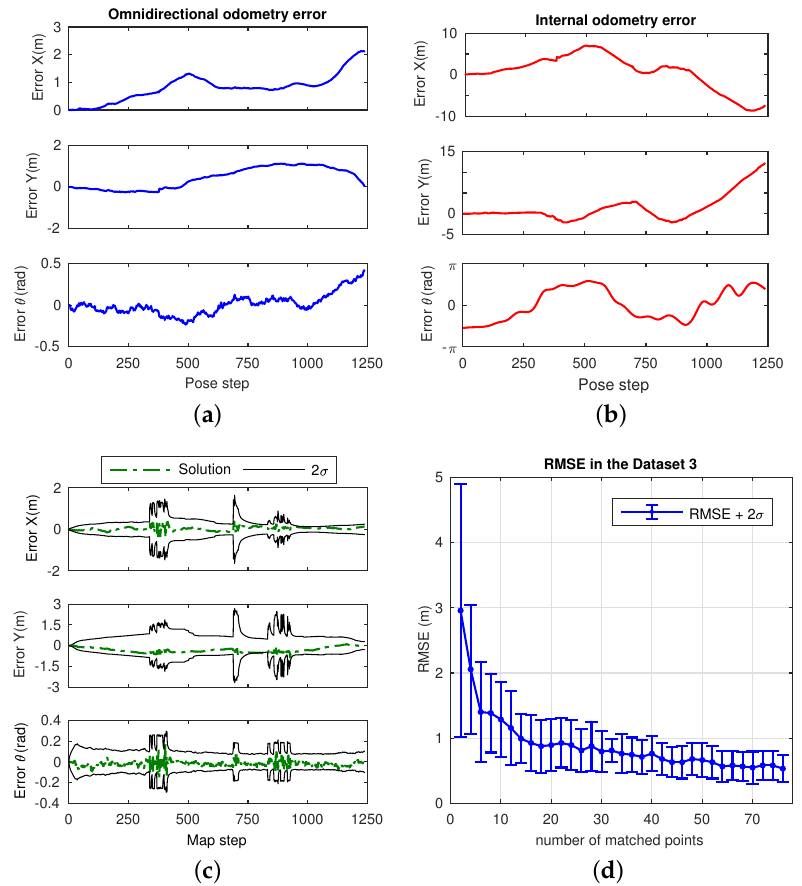
Figure 23. Error results in Dataset 3: ( a ) error in the omnidirectional visual odometry (Figure 22a) in X , Y and θ ; ( b ) error in the internal odometry for comparison purposes; ( c ) error terms for the SLAM estimation presented in Figure 22b; ( d ) RMSE (m) for the omnidirectional odometry with 2 σ versus the number of matched